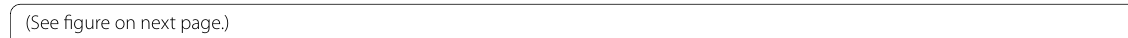
Fig. 3 BMSC-exosomes reduce mechanical allodynia by blocking activation of microglia cells. A Immunofluorescence was used for microglia identification; hind paw PWT ( B ) and PWL ( C ) of the rats that were intrathecally injected with microglial cells; Immunofluorescence ( D ) and western blotting ( E ) were used to detect the expression of OX42 in SDH. Data were shown as mean PBS group; # P < 0.05, vs. the SNL group. BMSC bone marrow mesenchymal stem cell, PWT paw withdrawal threshold, PWL paw withdrawal latency, SDH spinal dorsal